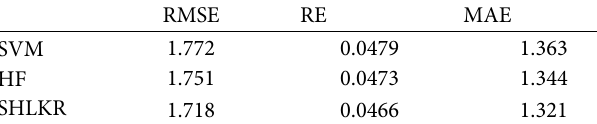
Figure 5: Error varying with . 𝑘 Table 1: Performance comparison between different